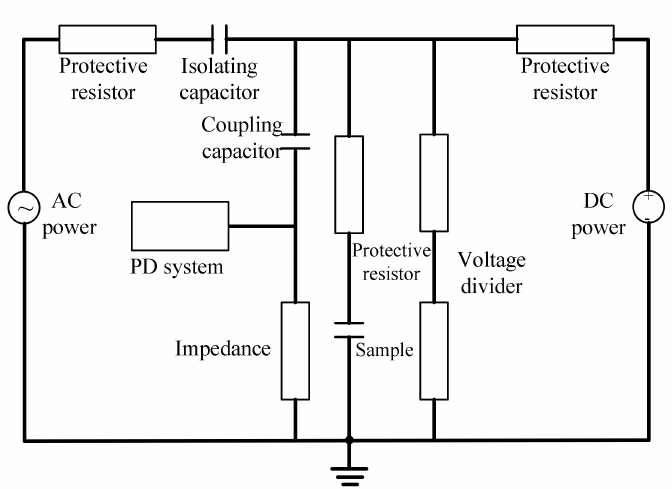
Figure 2. Schematic of the experimental